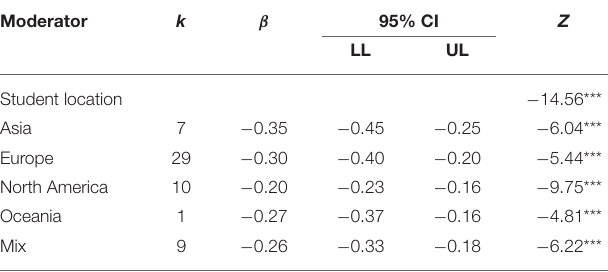
TABLE 5 | Student location as moderator of the BFLPE.